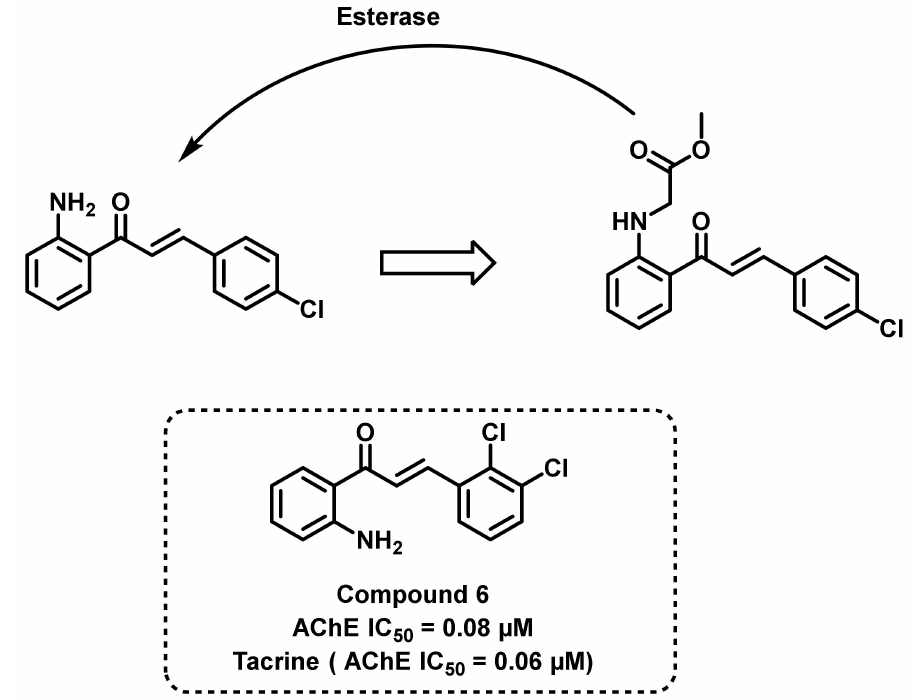
Figure 11. 2 (cid:48) -amino chalcones derivatives reported by Sakata et al.